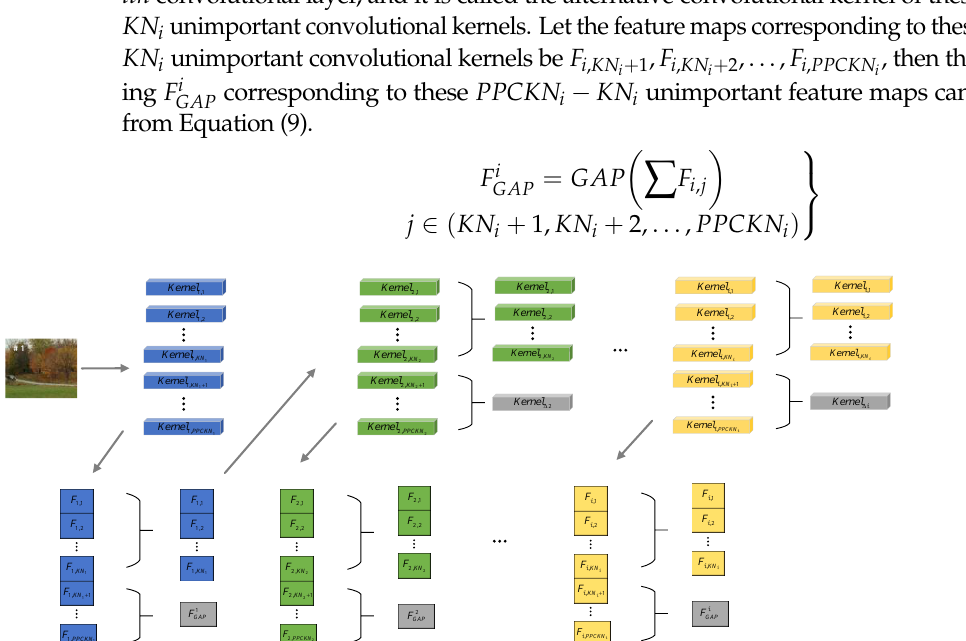
Figure 5. Initialization of the alternative kernels by applying the pre-pruned feature network to the first frame of the tracking video sequence. ( #𝑖 indicates the 𝑖 𝑡ℎ picture in the video sequence).